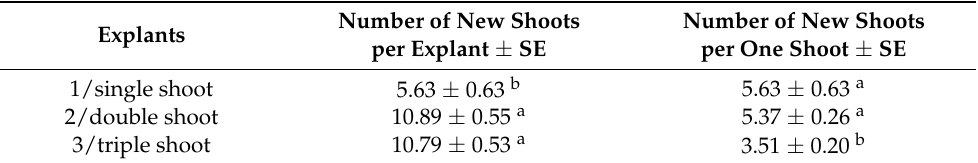
Table 2. The influence of the type of the plant explant (single, double, triple shoots) on Linnaea borealis var. borealis shoot multiplication on the solid MS medium with BAP 1.0 mg/L + IAA 0.1 mg/L + GA 3 1.0 mg/L.